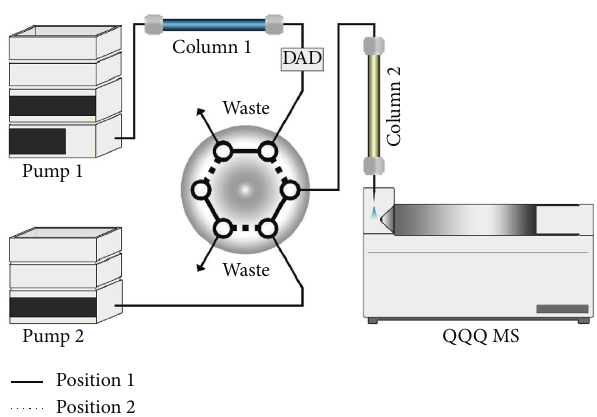
Figure 2: Schematic diagram of the developed 2D-LC-MS/MS system.